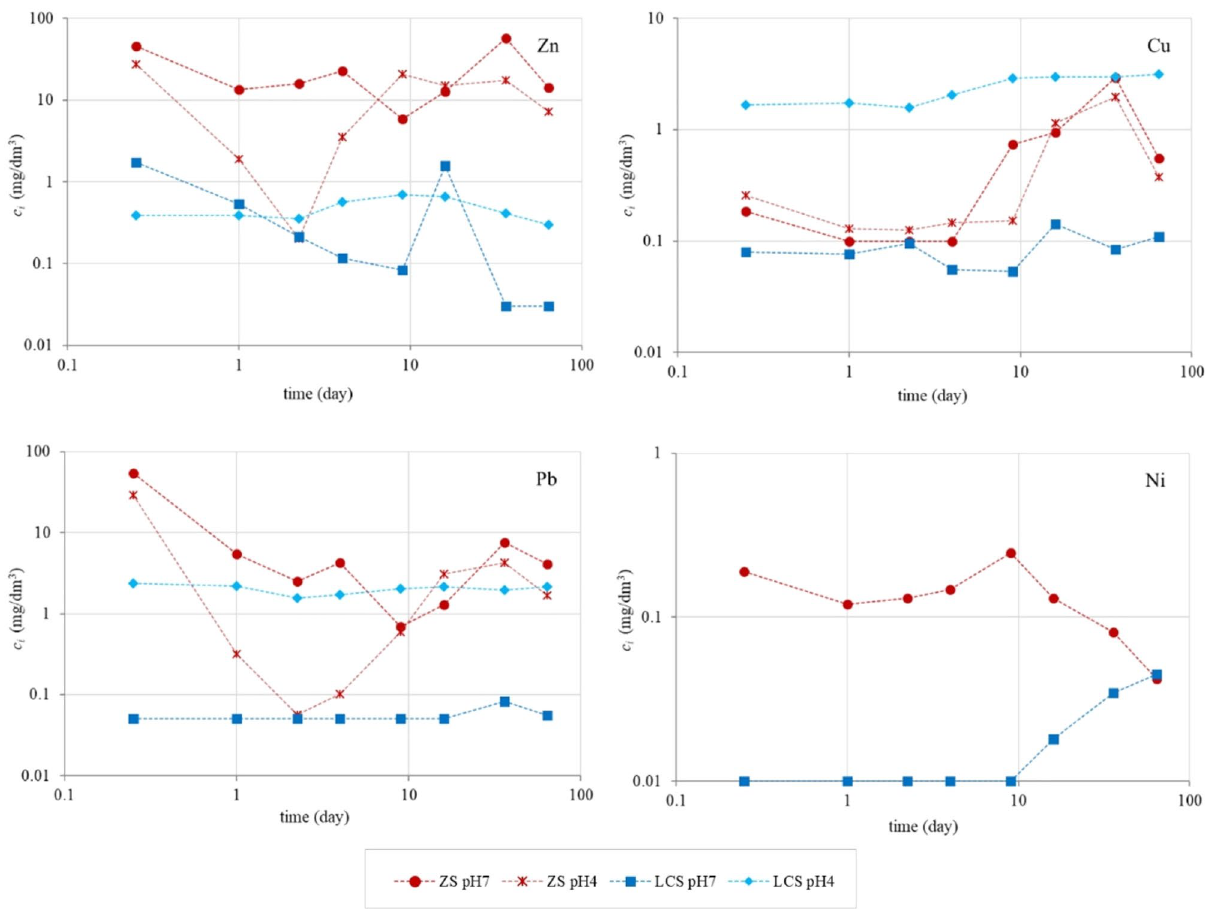
Figure 3. Concentration of Zn, Cu, Pb and Ni (in mg/dm 3 ) obtained in the tank test as a function of time.